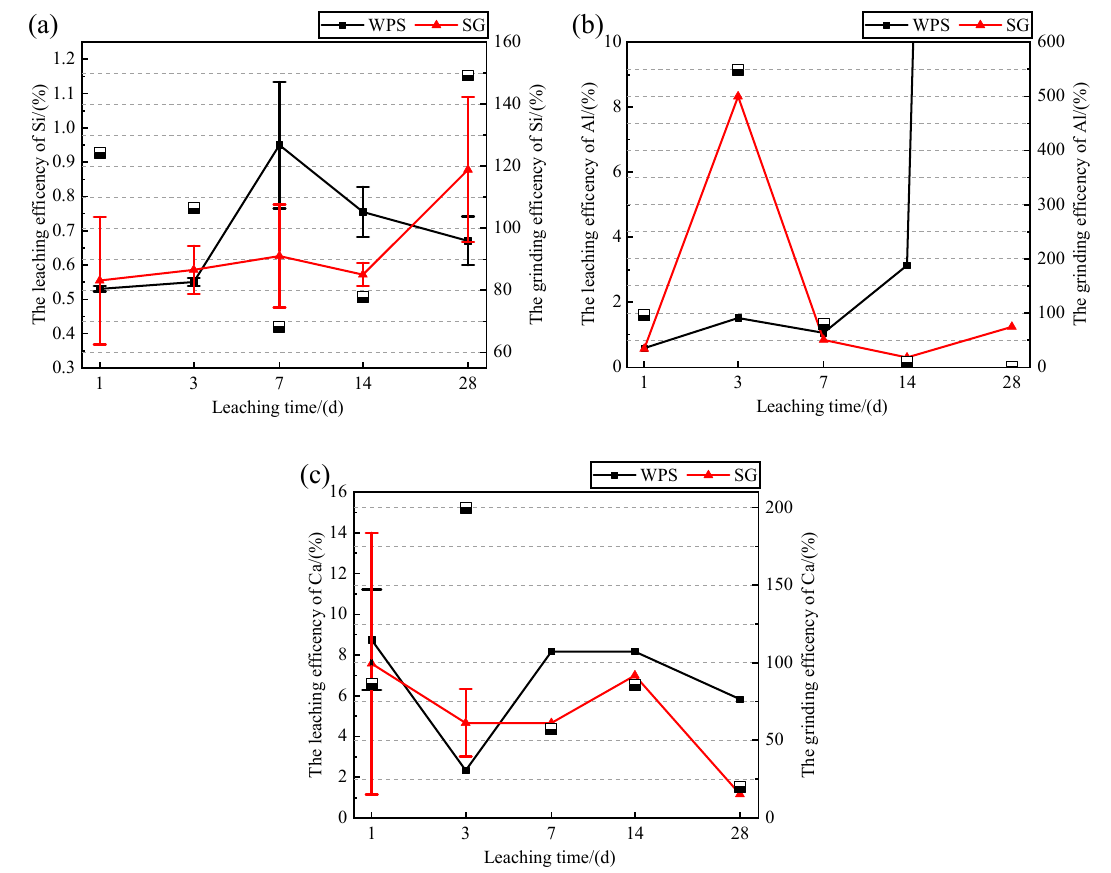
Figure 3. The grinding e ffi ciency between WPS and SG. ( a ) The ion leaching e ffi ciency of Si, ( b ) the ion leaching e ffi ciency of Al, and ( c ) the ion leaching e ffi ciency of Ca. (The plots in the fi gure corre- spond to the grinding e ffi ciency on the right axis).